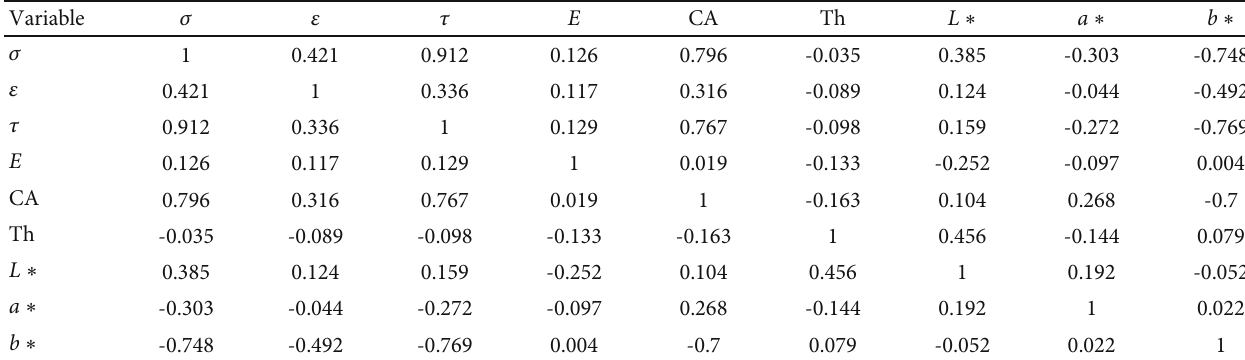
Figure 11: Representative loading plot of PCA correlation between properties: (a) group 0, (b) group 1, (c) group 2, and (d) group 3. Table 7: Coe ffi cient matrix of unaged PVDF-coated fabrics (group